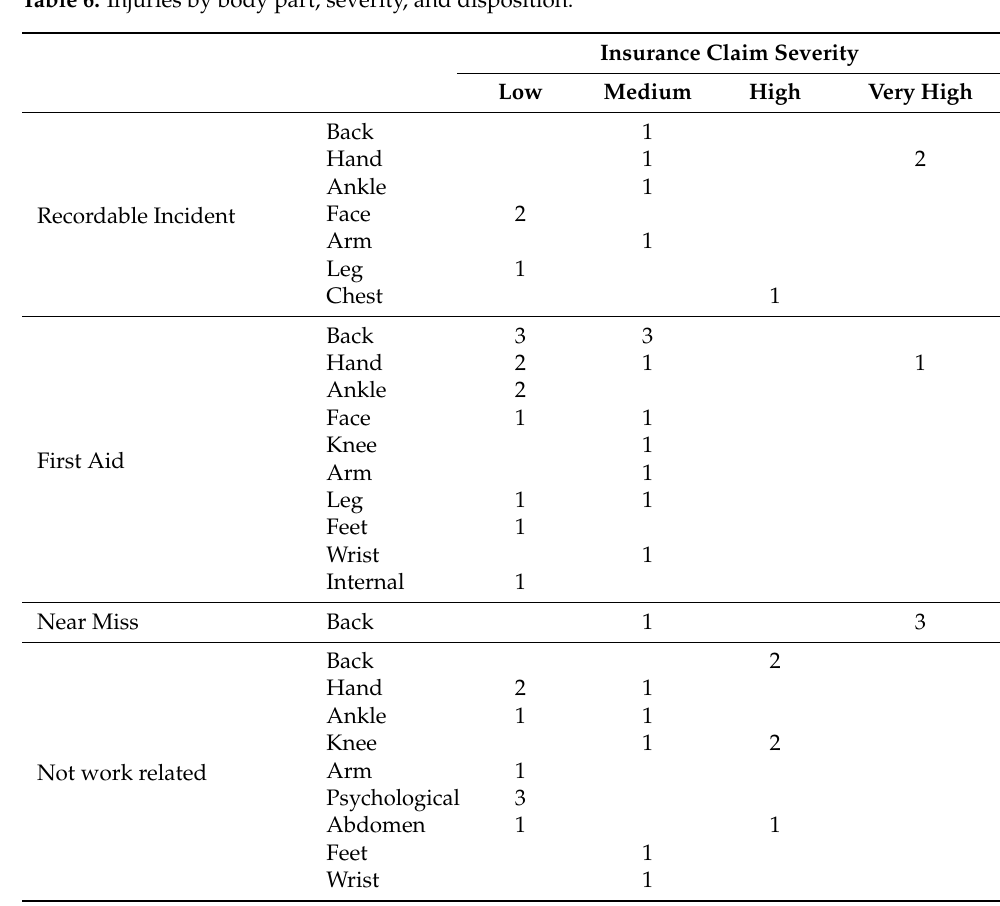
Figure 8 below is the same format as Figure 7 but broken down by injury